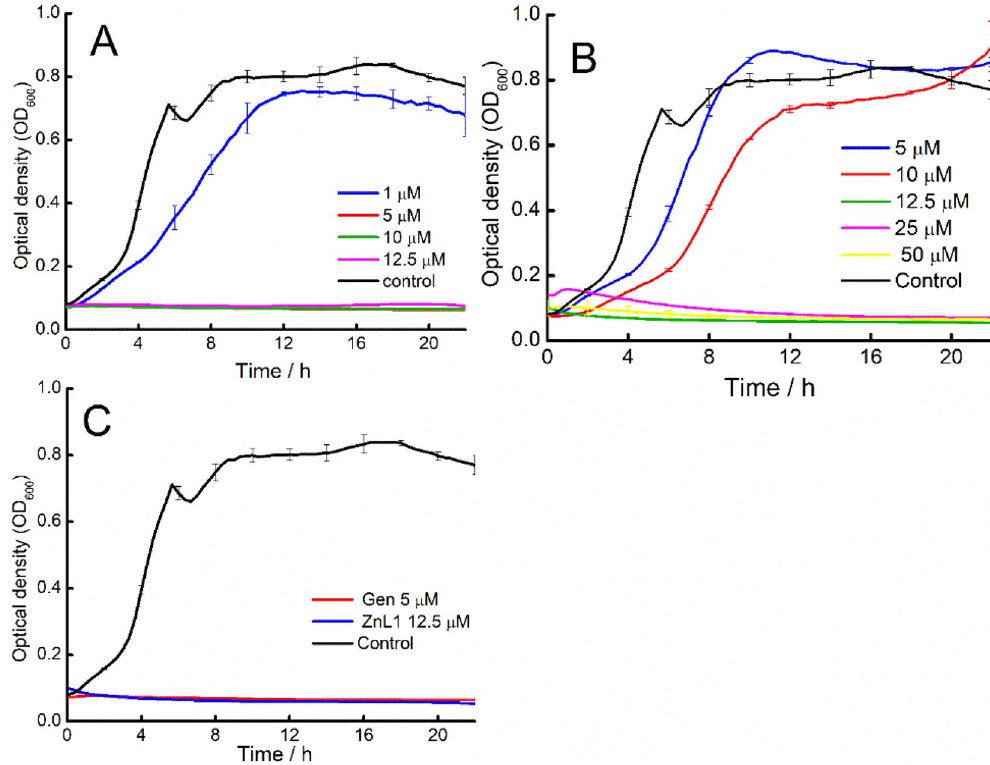
Figure 1. Effect of different concentrations of tested antibacterial compounds on growth of A. baumannii : ( A ) Gen; ( B ) ZnL1; ( C ) MIC of Gen and